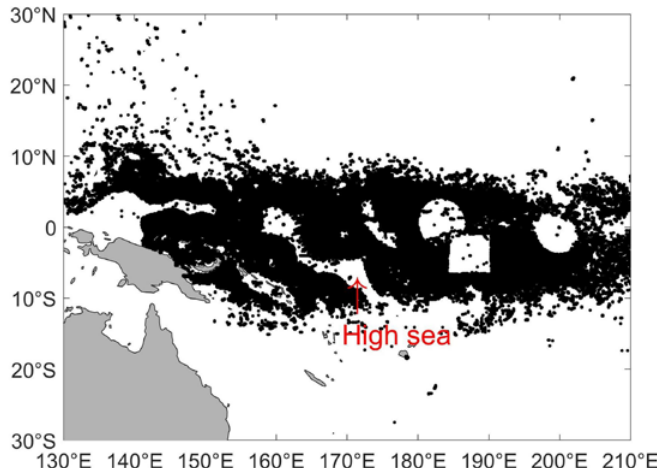
Figure 1. The spatial distribution of fishing locations during 2015–2020 (The red arrow points to an empty